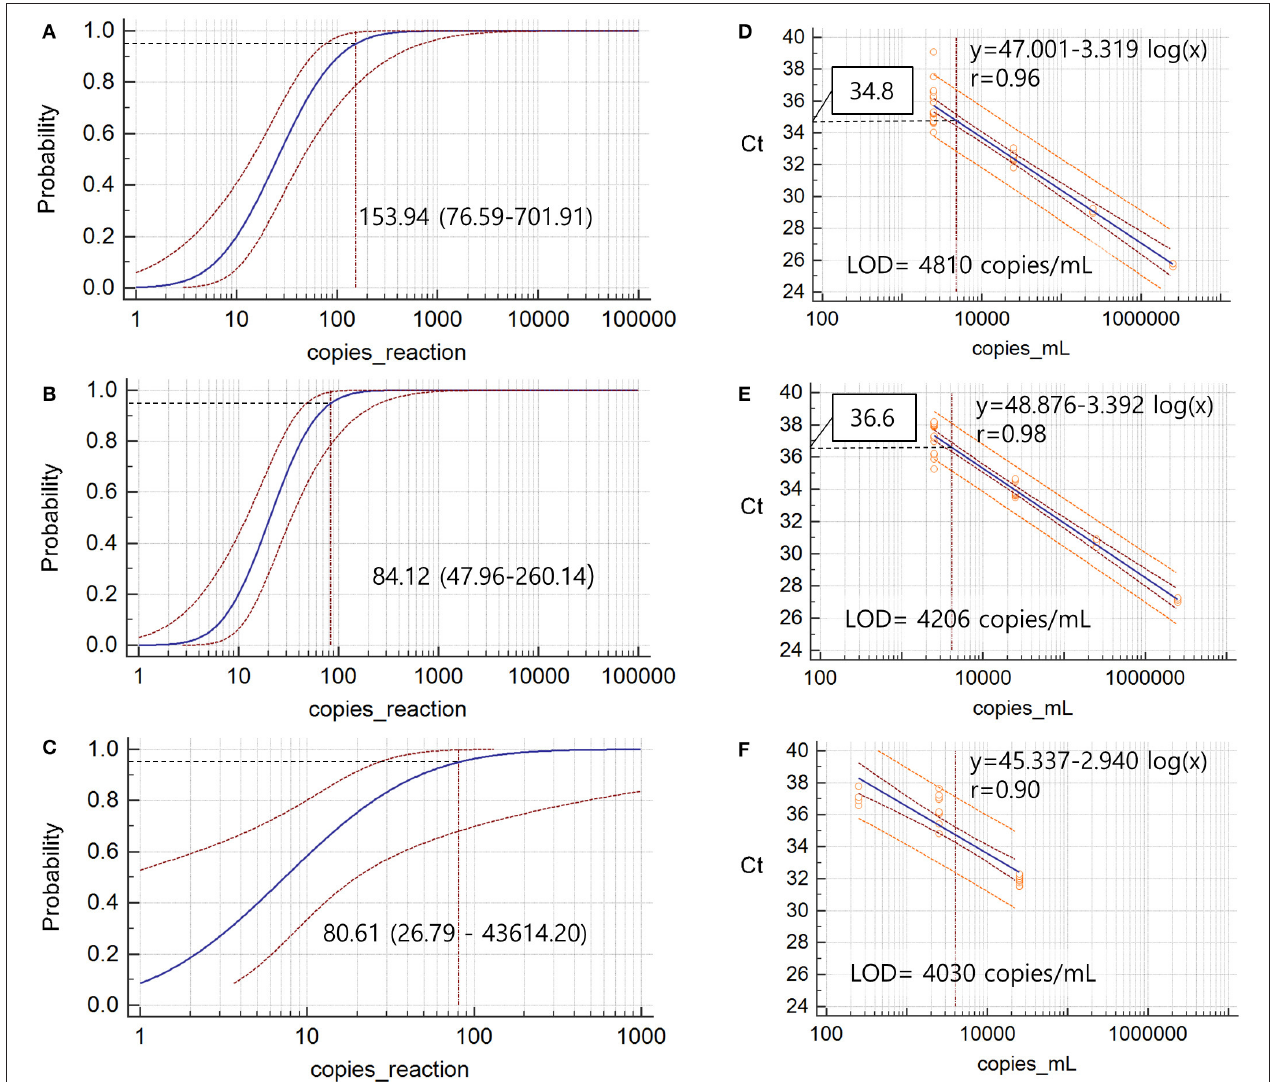
FIGURE 2 | The limits of detection of 95% (LOD) via probit analysis based on 20 replicates of serially diluted in vitro transcribed E RNA from SARS-CoV-2 for Allplex (A) and PowerChek (B) and 10 replicates of serially diluted purified RNA from SARS coronavirus Frankfurt1 for Real-Q (C) . Black dotted lines indicated LOD and values are denoted with 95% confidence intervals in parenthesis. The correlation between Cts and viral loads was analyzed via linear regression based on LOD experiments in Allplex (D) , PowerChek (E) , and Real-Q (F) . Open orange circles represent the results of each test. The Ct values corresponding to LOD of Allplex and PowerChek were calculated using the linear regression equation and are denoted by boxes.